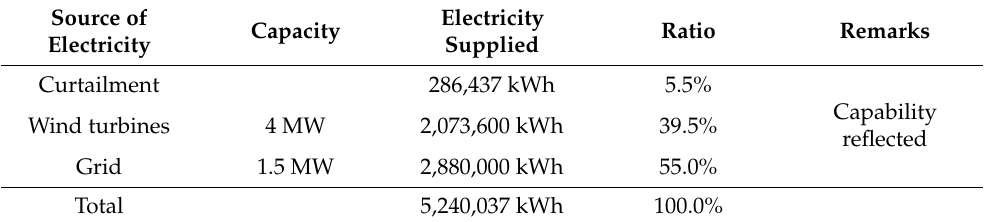
Table 21. The annual amount of electricity to be supplied to water electrolysis (Scenario III).